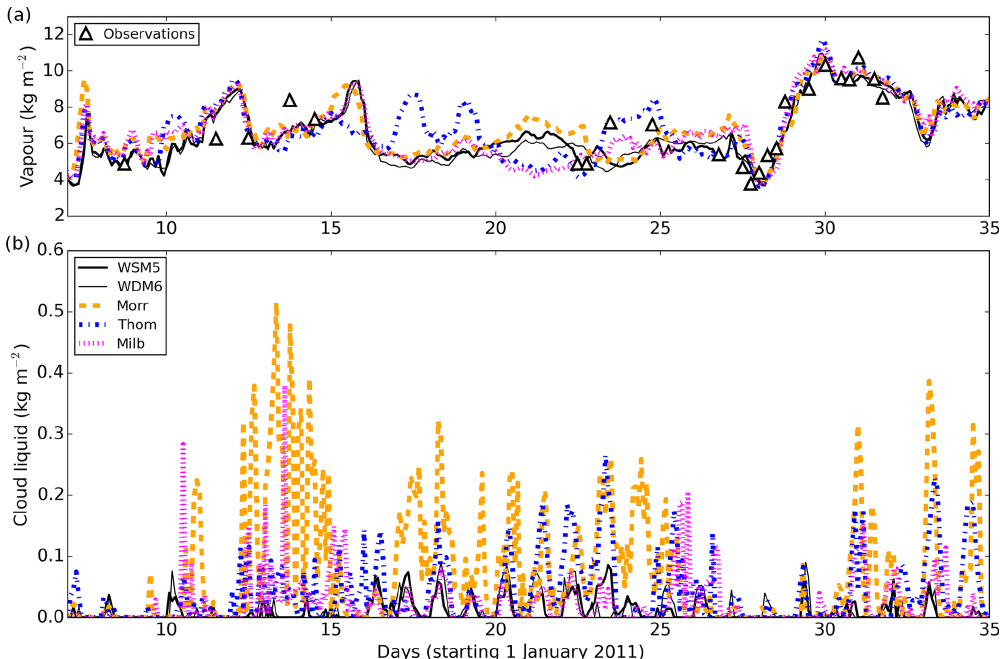
Figure 2. (a) Time series of column density of water vapour (kgm − 2 ) for the different simulations computed in the model grid box corre- sponding to the AWS14 location in 2011, along with the radiosonde measurements from the field camp (described in K15; see their Fig. 7). (b) Time series of the column density of the cloud liquid (kgm − 2 ) for the different simulations.